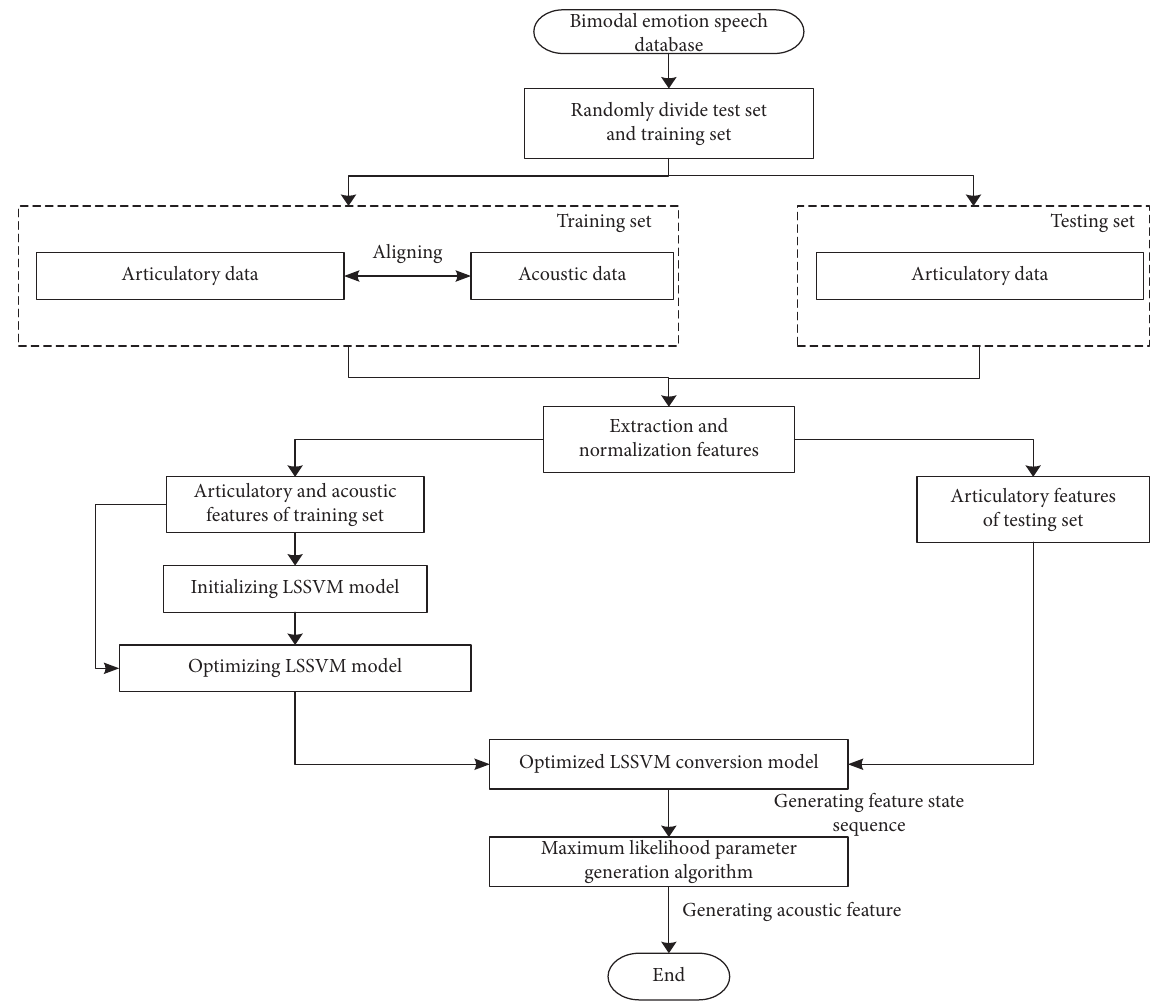
Figure 1: Articulatory-to-acoustic conversion model based on